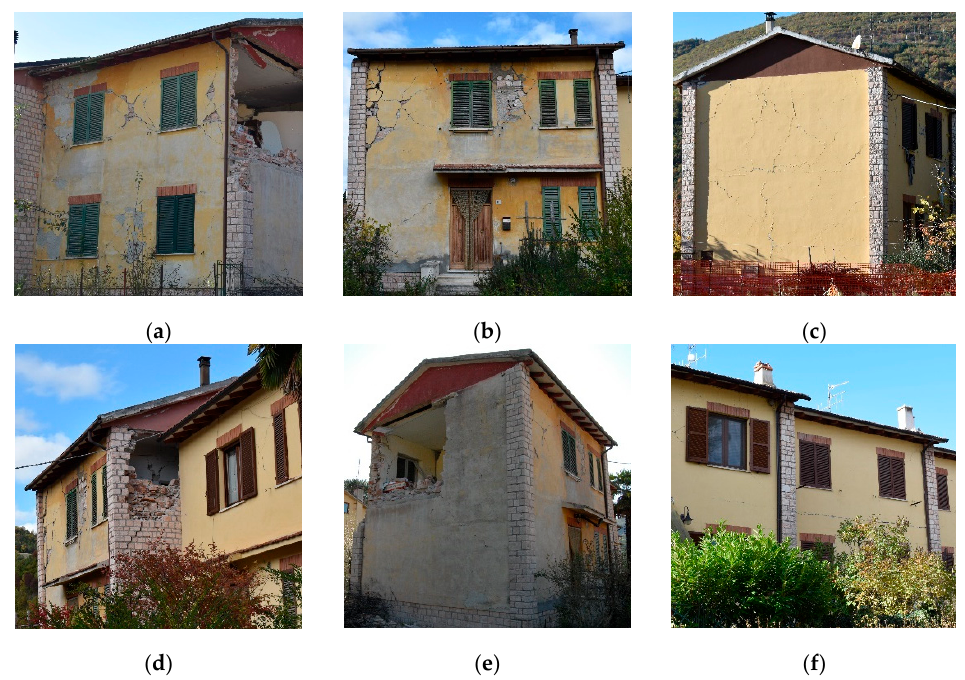
Figure 8. Details of damage pattern in IACP building: diagonal shear cracks of piers in ( a ) north and ( b ) south facades of unit no. 6, and activation of overturning in west facade; ( c ) shear cracks in east facade of unit no. 1; crumbling and overturning in ( d ) east and ( e ) west facades of unit no. 6; ( f ) sliding cracks at floor level in unit no. 4.